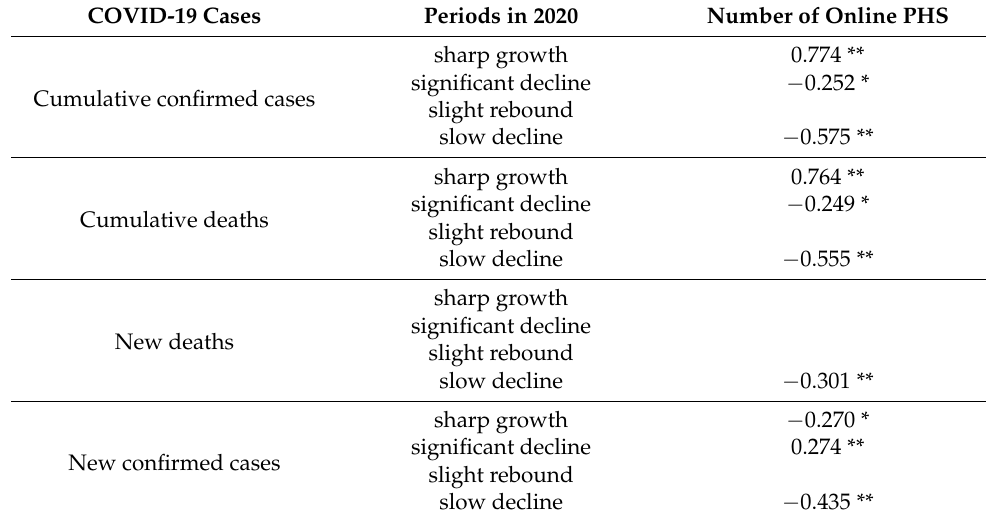
Table 3. Correlations between the COVID-19 cases and the number of PHS posts due to different